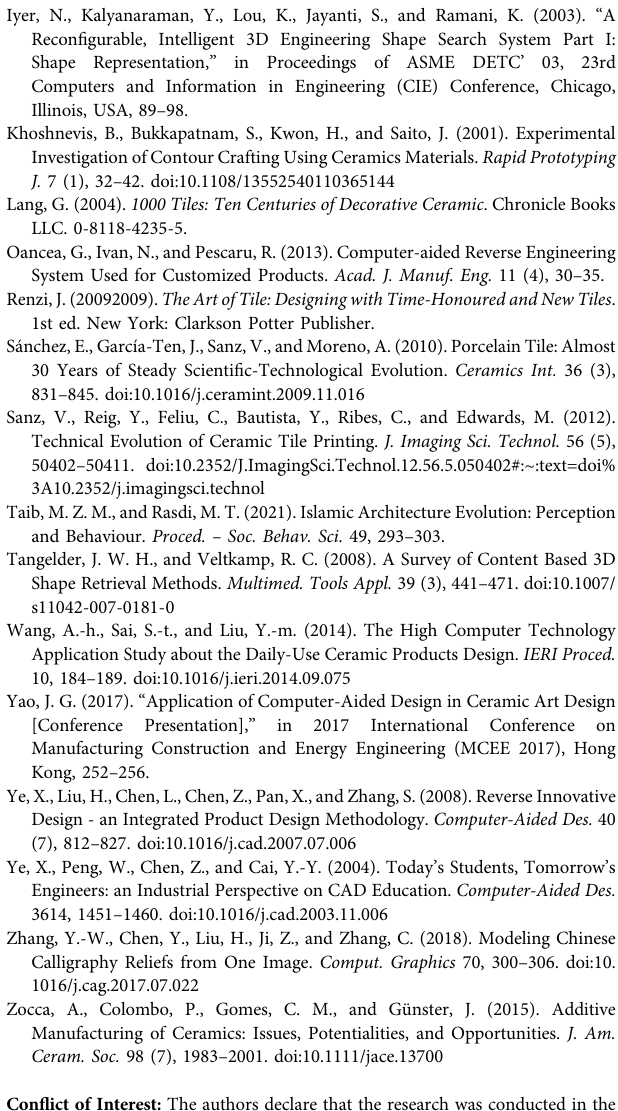
Ceramic Tableware. Part I: 3-D Decoration. Comput. Graphics 21 (5), 641 – 653. PII: SOO97-8493(97)00041-1. doi:10.1016/s0097-8493(97)00041-1 Chua, C. K., Gay, R., and Hoheisel, W. (1997b). Computer Aided Decoration of Ceramic Tableware. Part II: Rapid Tooling. Comput. Graphics 21 (5), 655 –